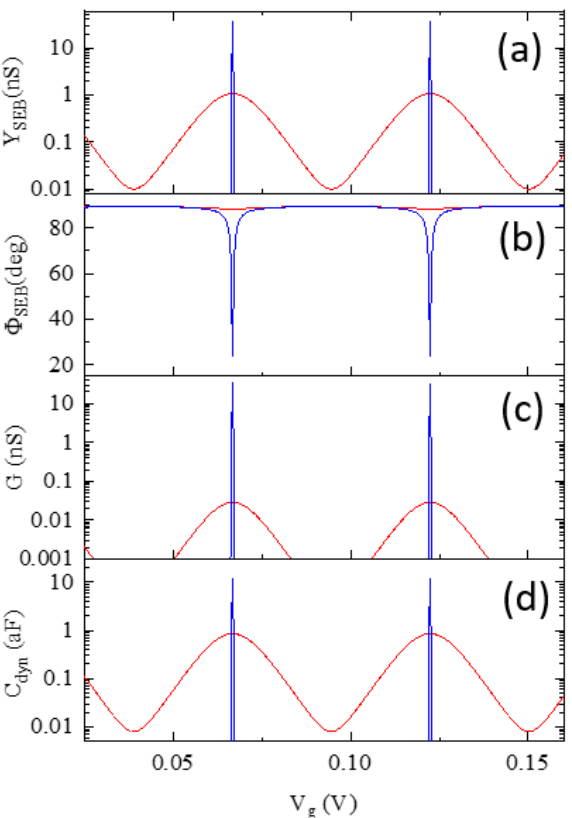
Figure 2. Complex admittance oscillations vs. V g and respective components of it ( a ) magnitude; ( b ) phase; ( c ) inverse of Sisyphus resistance and ( d ) dynamic capacitance for single SEB calculated using Formula (1) at two temperatures: 50 mK (blue) and 4.2 K (red).